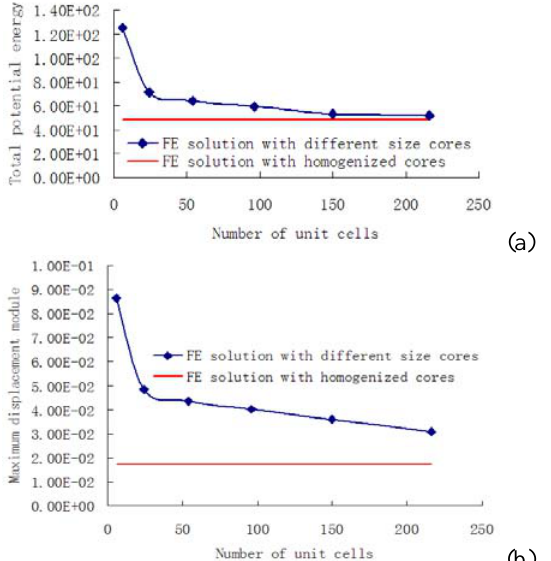
omoFig.14. FE solution of sandwich structure with the